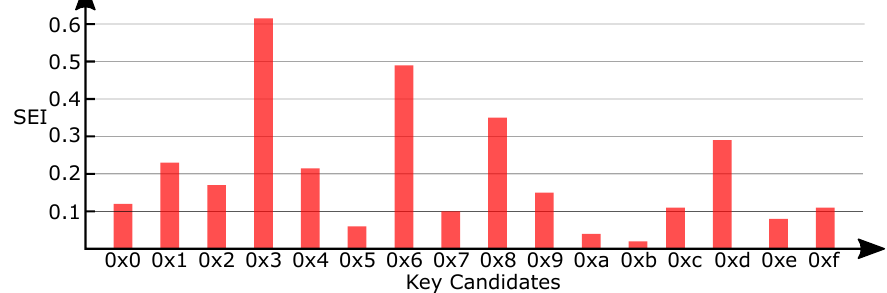
Figure 10: The result of our SEI test for the different key